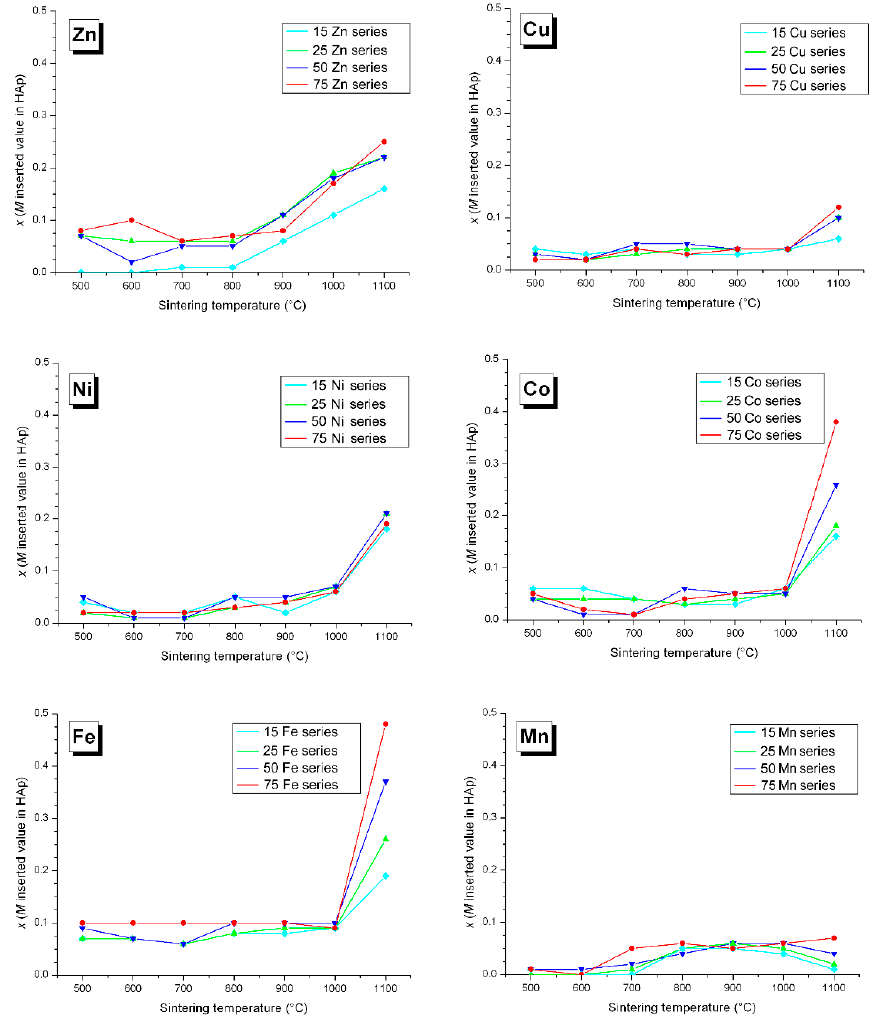
Figure 10. Variation in the x refined M amount inserted into the HAp structure, considering the Ca 10 M x (PO 4 ) 6 (OH) 2 − 2 x O 2 x composition, for all the Zn-, Cu-, Ni-, Co-, Fe-, and Mn-doped samples: light blue lines for the 15 M -T series, green lines for the 25 M -T series, dark blue lines for the 50 M -T series, and red lines for the 75 M -T series. The lines are only visual guides.